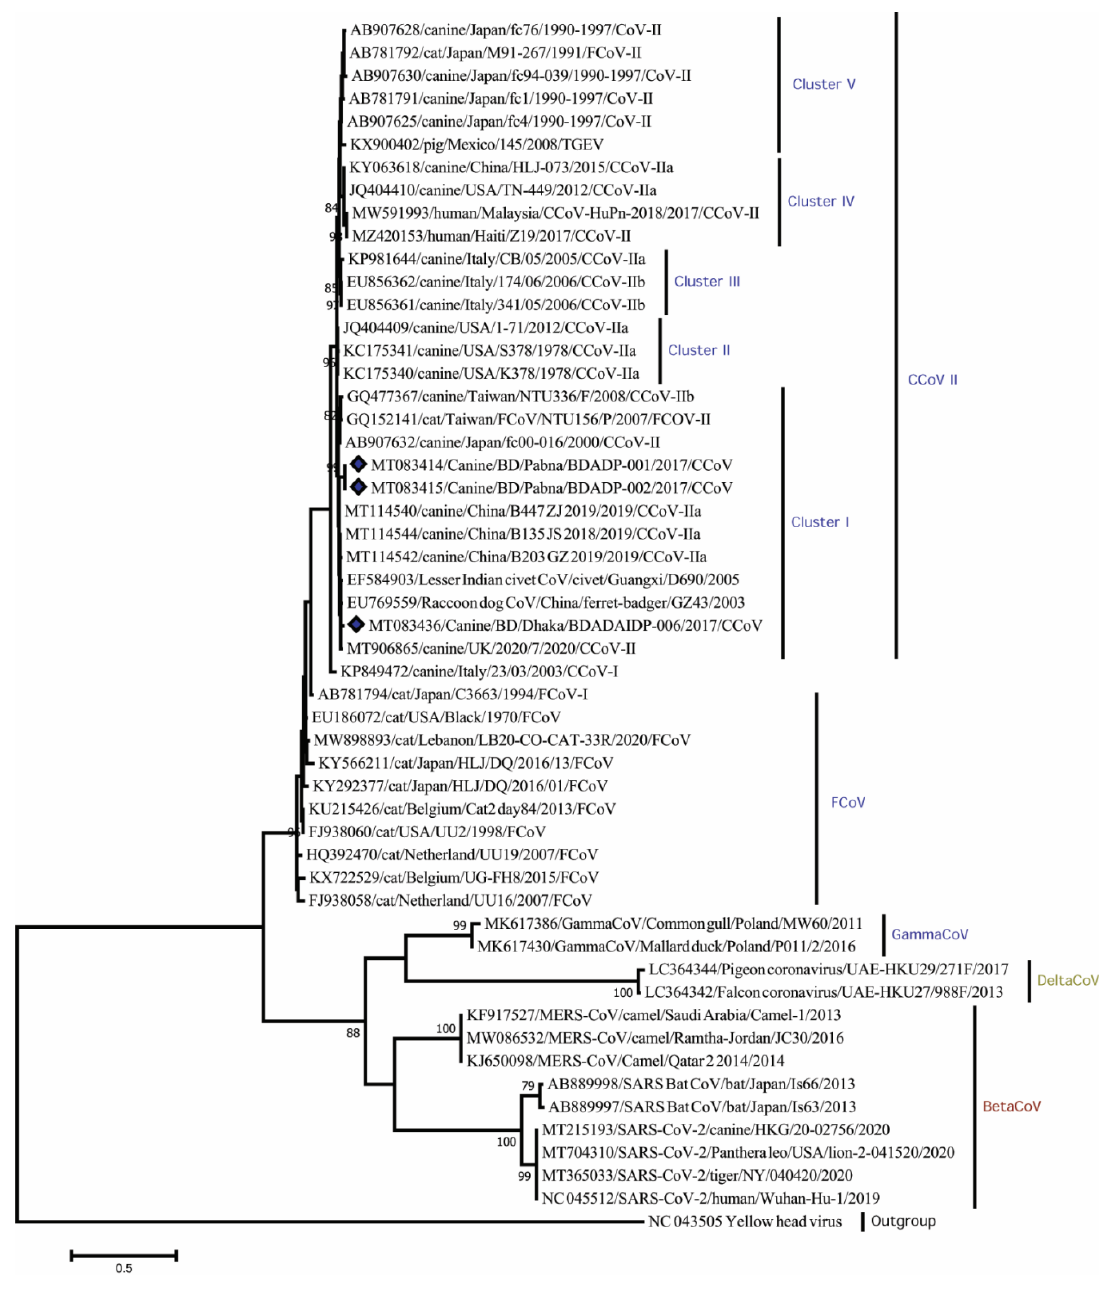
Figure 2. Maximum Likelihood phylogenetic tree based on the partial RdRp sequence of Coronaviri- dae. CCoV strains in this study are indicated by rhombus (blue colored). The tree was calculated using the Maximum Likelihood method with the Kimura 2-parameter distance model. The percent- ages of replicate trees (>70%) in which the associated taxa clustered together in the bootstrap test (1000 replicates) are shown next to the branches. RdRp, RNA dependent RNA polymerase; CCoV, canine coronavirus; CCoV-I, canine coronavirus type I; CCoV-II, canine coronavirus type II;